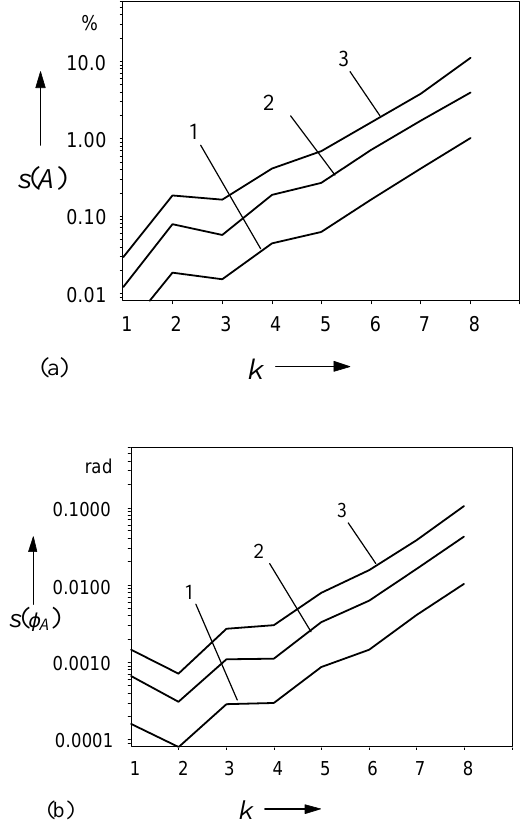
Fig. 8. (a) Relative amplitude standard deviation, s (A), and (b) stan- dard deviation of phase values, s ( ϕ A), of the acceleration spectrum obtained for contamination of the phase sequence ϕ ( n ) by